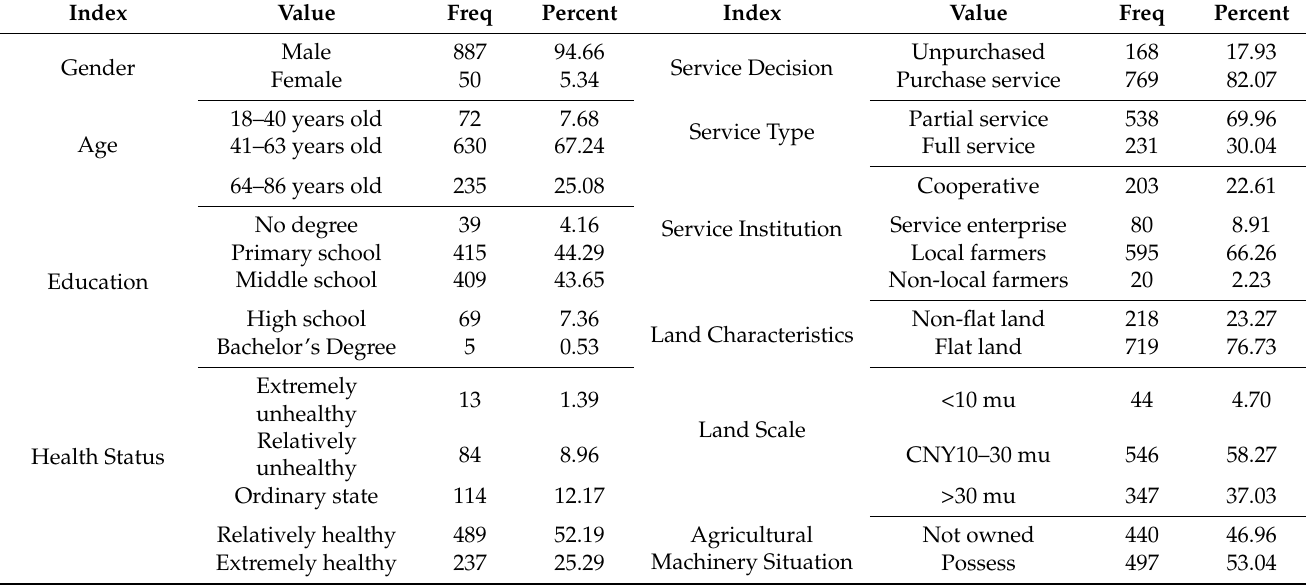
Table 1. Basic characteristics of sample (Unit: farmer,